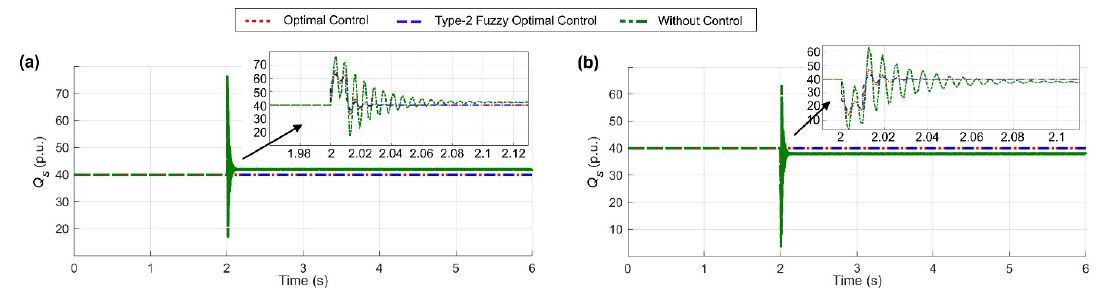
Figure 8. Control system operation (with and without type-2 fuzzy system) and without controller to ( a ) decrease and ( b ) increase DFIG parameters by 20%.